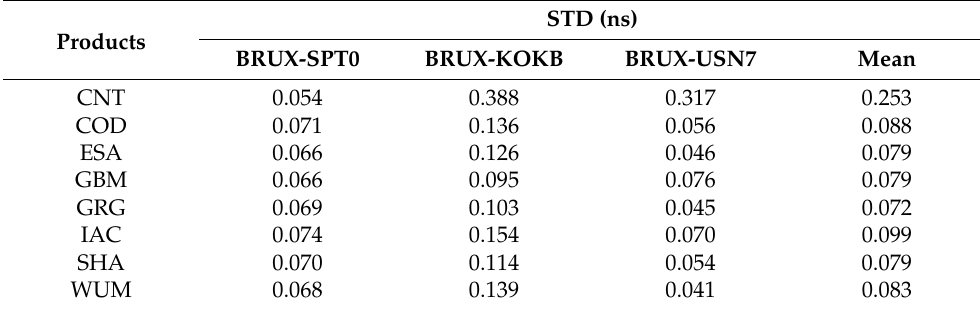
Figure 11. Differences of the time links between Galileo five-frequency PPP estimates with different precise products and IGS final products on DOY 248, 2021. Table 4. STD values of differences of the time links between PPP estimates and IGS final products on DOY 248,